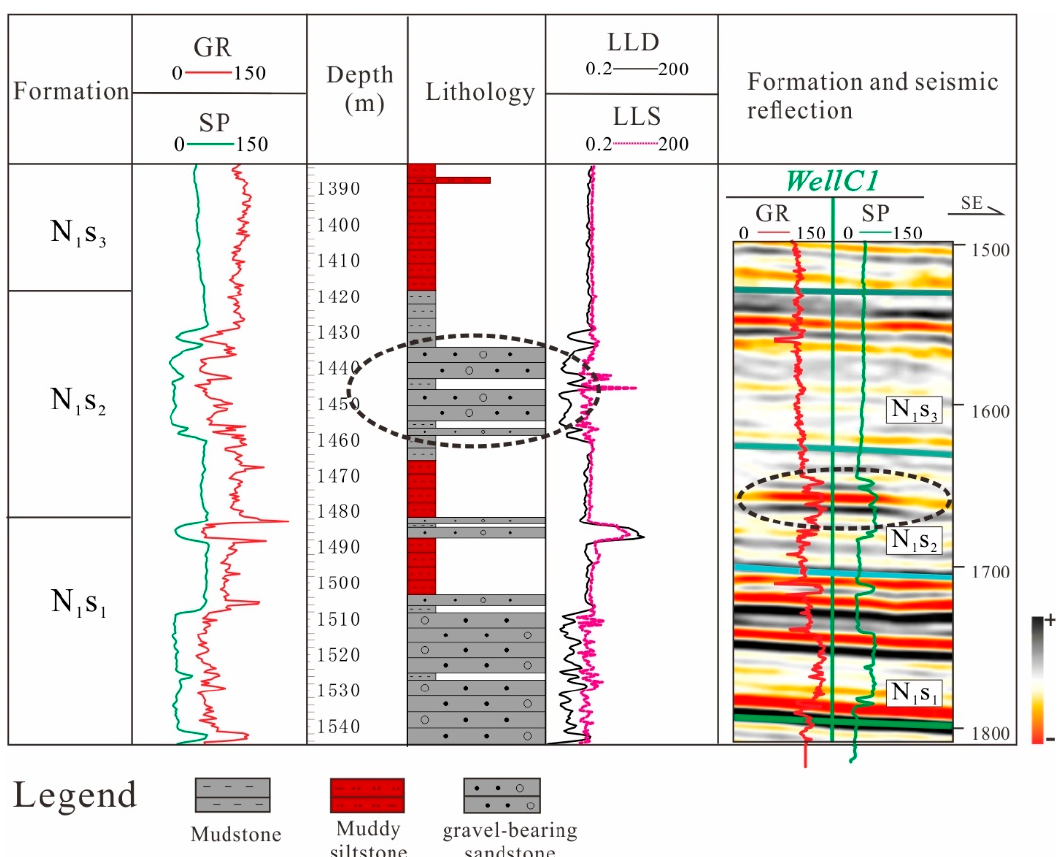
Figure 5. The well log recording of Well C1 in Figure 4. The dashed circle indicates the location of the seismic geological channel.